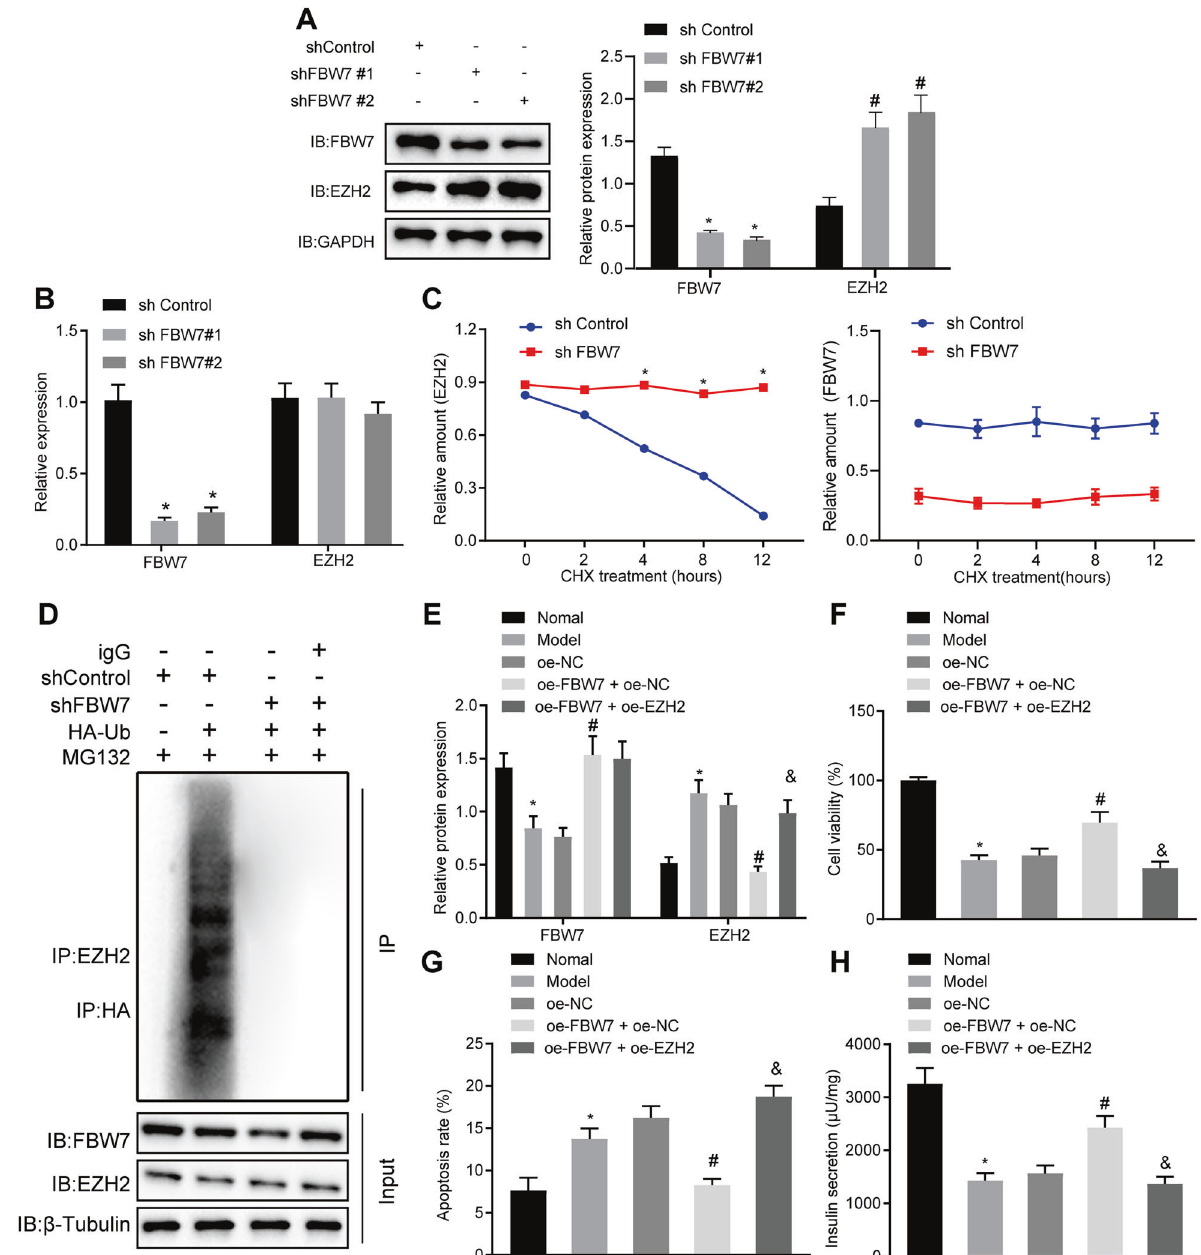
Fig. 3 FBW7 inhibits TNF- α -induced pancreatic beta-cell apoptosis and dysfunction through ubiquitin degradation of EZH2. A Western blot assay of Min6 cells treated with MG132, B Western blot assay of Min6 cells transfected with shFBW7, * p < 0.05 vs. the shControl group in FBW7 blotting, # p < 0.05 vs. the shControl group in EZH2 blotting. C RT-qPCR quanti fi cation of FBW7 and EZH2 mRNA in Min6 cells transfected with shFBW7, * p < 0.05 vs. the shControl group. D Western blot analysis of EZH2 after CHX treatment at different time points, EZH2 was fi rst normalized to GAPDH then normalized to time 0 at each time point, * p < 0.05 vs. the shControl grou p . E After 48 h of transfection of designed plasmid, the Min6 cells were incubated with the MG132 (20 μ M) for 8 h, Western blot analysis of the EZH2 ubiquitination following with IP assay. F Western blot assay of the FBW7 and EZH2 proteins in the FBW7-, or with EZH2-, overexpressed Min6 cells, * p < 0.05 vs. the normal group, # p < 0.05 vs. the OE-EZH2 + OE-NC group, & p < 0.05 vs. the OE-EZH2 + OE-FBW7 group. G CCK-8 assay for cell viability in each group, * p < 0.05 vs. the normal group, # p < 0.05 vs. the OE-EZH2 + OE-NC group, & p < 0.05 vs. the OE-EZH2 + OE-FBW7 group. H fl ow cytometry determination for apoptosis in each group, * p < 0.05 vs. the normal group, # p < 0.05 vs. the OE- EZH2 + OE-NC group, & p < 0.05 vs. the OE- EZH2 + OE-FBW7 group. I Determination of insulin secretion, * p < 0.05 vs. the normal group, # p < 0.05 vs. the OE-EZH2 + OE-NC group, & p < 0.05 vs. the OE-EZH2 + OE-FBW7 group. All experiments were conducted in triplicate. Data comparisons between two groups were analyzed by unpaired t -test. Comparisons among multiple groups were performed by one-way ANOVA. Statistical analysis in relation to time- based measurements within each group was realized using repeated-measures ANOVA.